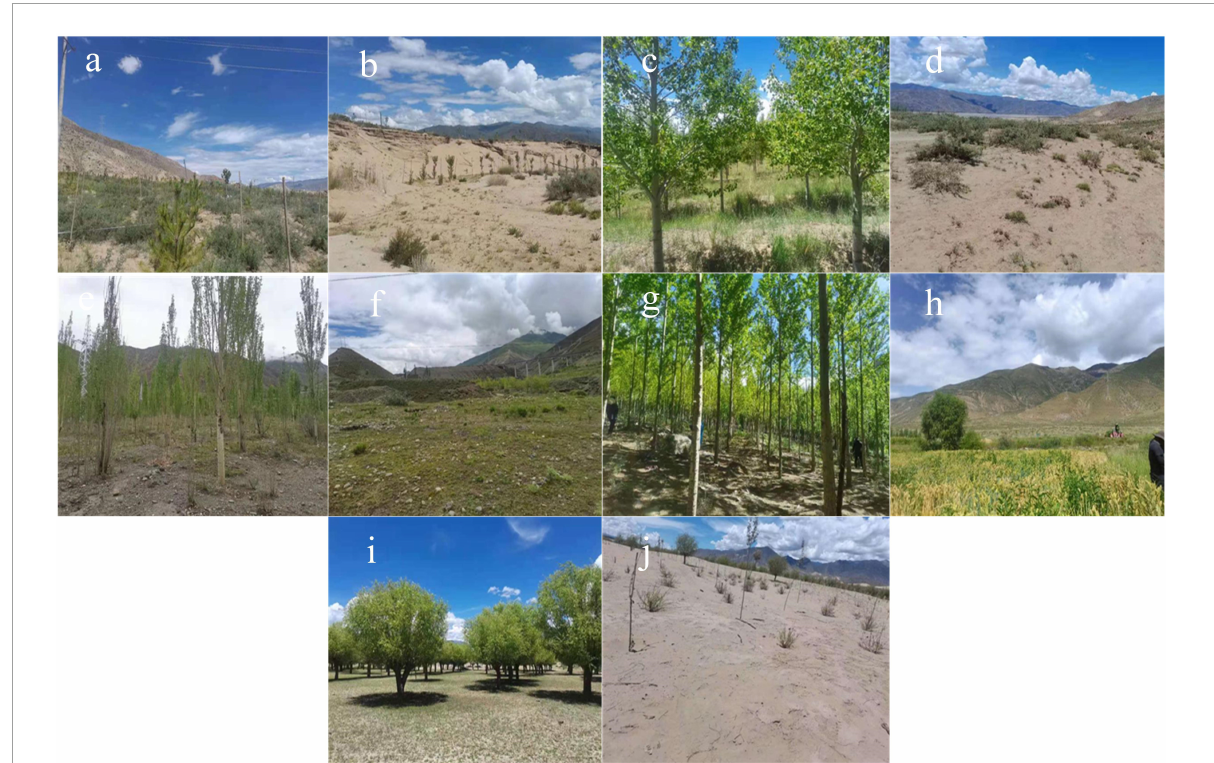
FIGURE2 Sample plot landscape of artificial afforestation at different times. Panels (a) and (b) , (c) and (d) , (e) and (f) , (g) and (h) , (i) and (j) are artificial afforestation and control plot for 2, 5, 11, 15, and 31 years, respectively.